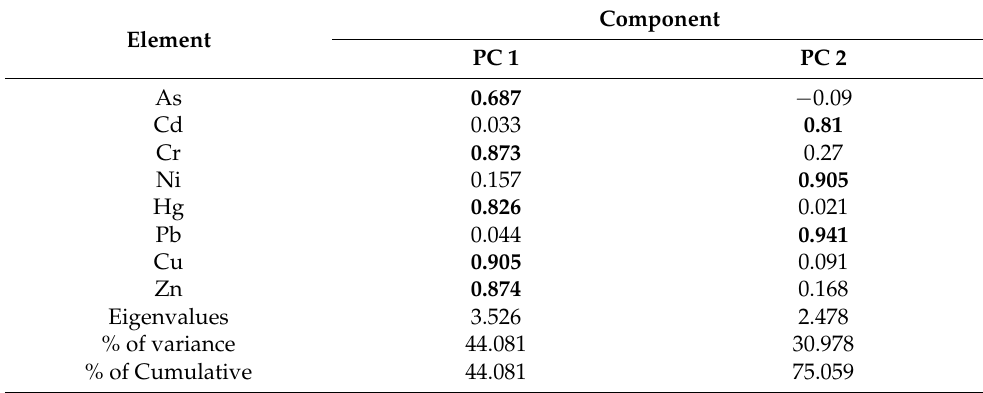
Table 7. Principle component analysis of heavy metals in irrigation cropland